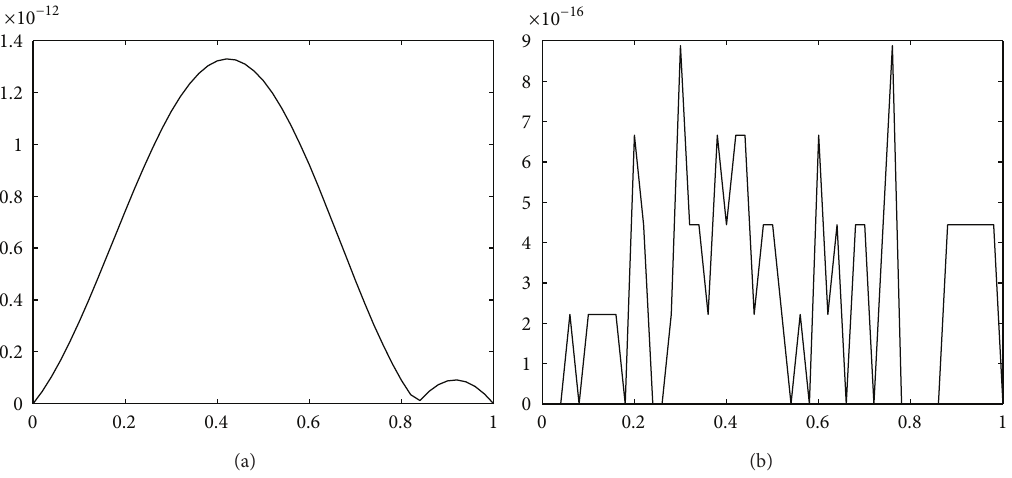
Figure 5: Error function of problem (66) for 𝑚 = 3 (a) and for 𝑚 = 6